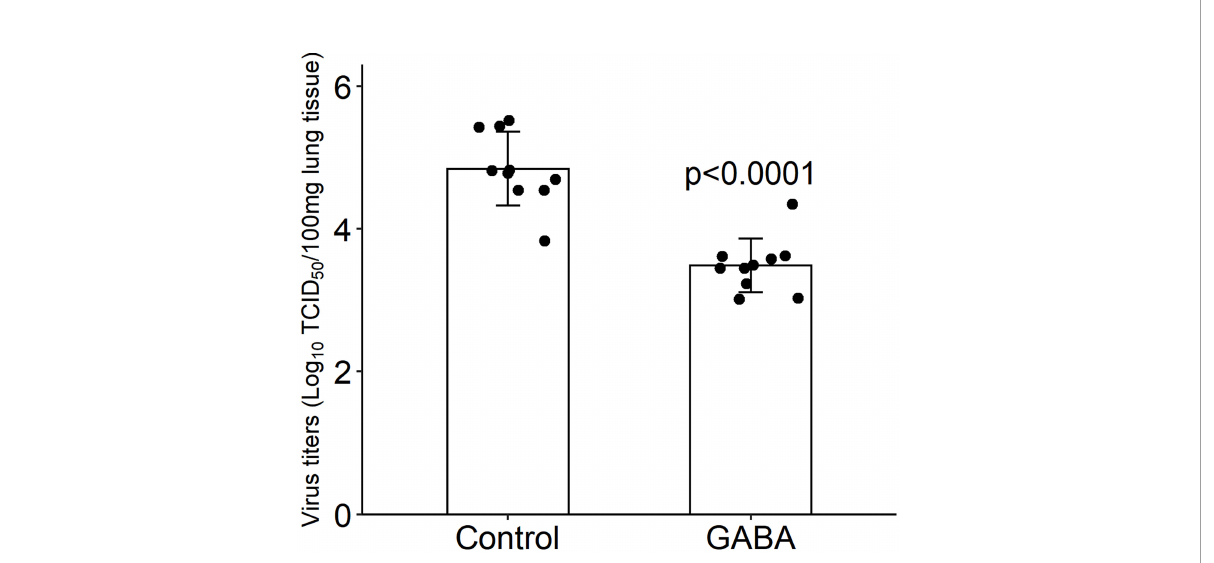
FIGURE 2 GABA treatment reduces SARS-CoV-2 titers in the lungs. Three days post-infection the right lung was harvested from each mouse and homogenized. The viral titer in lung tissue (100 mg) were determined by TCID 50 assay using Vero E6 cells. Black dots show viral titers for individual mice (determined in quadruplicate). The data shown are the mean virus titer (Log 10 TCID 50 /100 mg lung tissue) ± SD in mice given plain water (control) or GABA. N=10 mice/group. The p-value was determined by Student ’ s